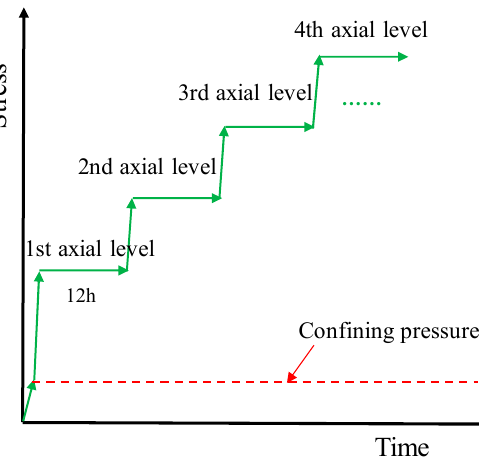
Table 2. Results of conventional triaxial compression tests. Figure 3. Loading method used in creep test. Figure 3. Loading method used in creep test.